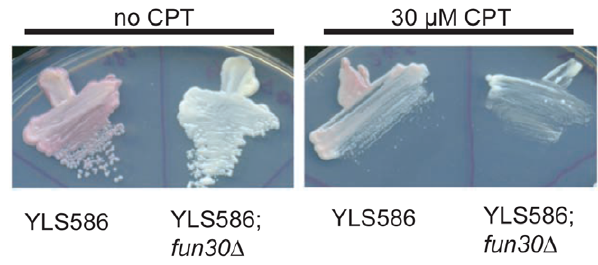
Figure 8. Camptothecin does not abrogate silencing within the HMR . Silencing reporter strains YLS586 or YLS586; fun30 D (see Figure 4) were grown on minimal glucose medium, 1% DMS0 with or without 30 m M camptothecin (CPT) and the accumulation of red pigment, indicative of silencing of the ADE2 reporter gene embedded in the HMR, was monitored as in Figure